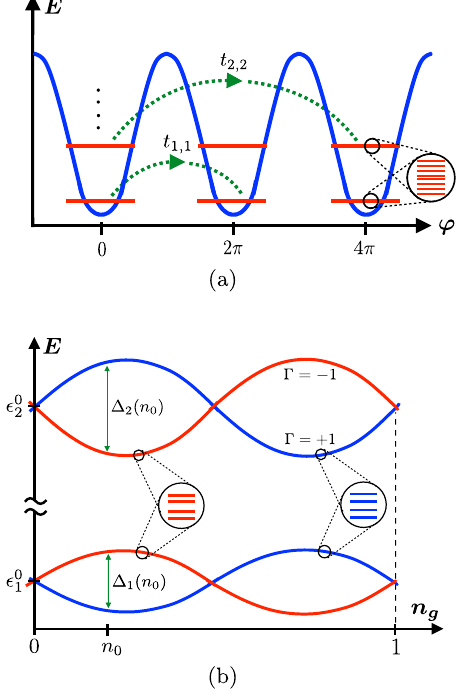
FIG. 5. (a) Schematic of the harmonic oscillator energy levels of the effective Hamiltonian (17), centered at φ ¼ 2 π n , with the 2 π and 4 π phase-slip amplitudes for the lowest energy levels shown. In (b), we show a schematic plot of the two lowest harmonic oscillator levels as a function of the gate charge. The energy splittings Δ 1 and Δ 2 are between states with even ( Γ ¼ þ 1 ) and odd fermion parity ( Γ ¼ − 1 ) within the first and second harmonic oscillator levels, respectively. Each level within a fixed fermion parity sector is nearly four-fold